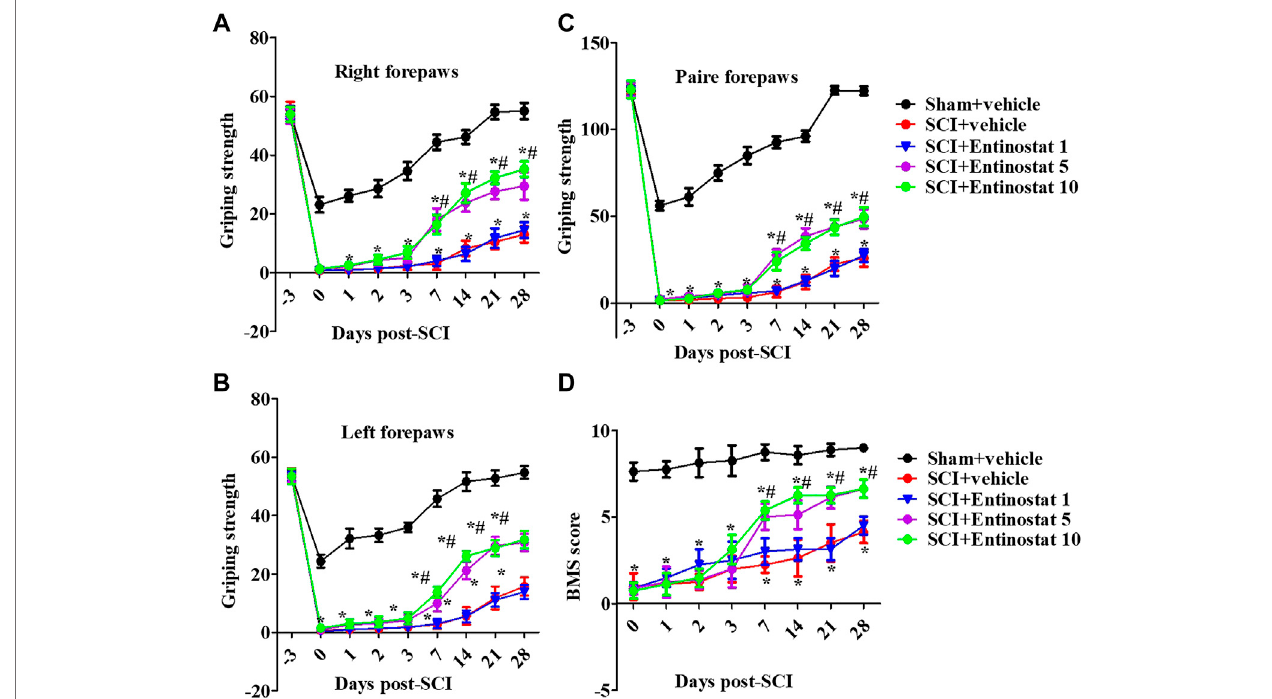
FIGURE1| EntinostatimprovesthemotorfunctionfollowingSCI.BehavioraltestsofSCImicewithentinostat(1,5,or10 mg/kg)ornotandthegrip strengthofthe right forepaw (A) , left forepaw (B) , and paired forepaws (C) was measured before the experiment and after surgery. (D) Measurement of the BMS score after SCI. Data areexpressedasthemean ± SEM, n (cid:1) 8.* p < 0.05, vs. thesham+vehiclegroup;# p < 0.05, vs. theSCI+vehiclegroup.BMS:bassomousescale.SEM:standarderror of the